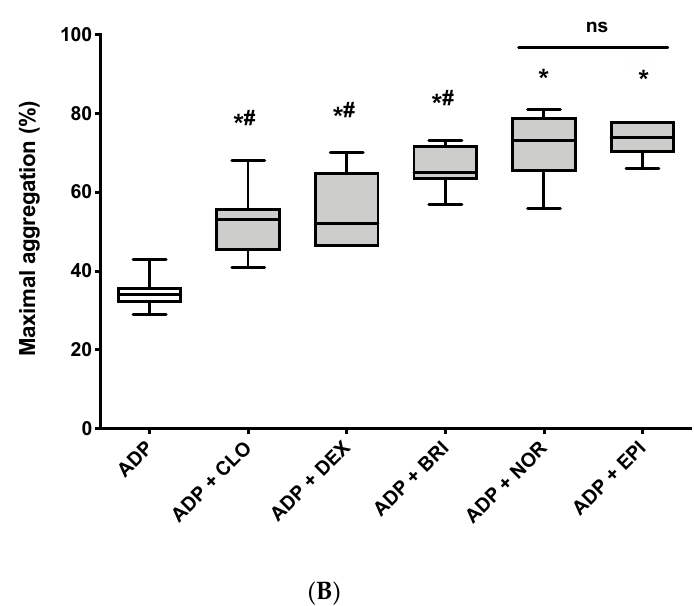
Figure 1. All α 2-adrenoreceptor agonists potentiate adenosine diphosphate (ADP)-induced platelet aggregation in the absence of ticagrelor. Washed platelet aggregation on stimulation with different agonists (5 µ M ADP alone or in combination with clonidine (CLO, 10 µ M), dexmedetomidine (DEX, 8 µ M), brimonidine (BRI, 10 µ M), norepinephrine (NOR, 10 µ M), or epinephrine (EPI, 10 µ M)). ( A ) Typical time-course of platelet aggregation using light transmission aggregometry. ( B ) Comparison of percentage of the maximal aggregation ( n = 7). Boxes represent the interquartile range and the median value, whiskers and the minimum and maximum values observed. All samples were compared with ADP alone (* p < 0.01 vs. ADP alone), and with the combination of ADP and EPI (# p < 0.05 vs. ADP + EPI).